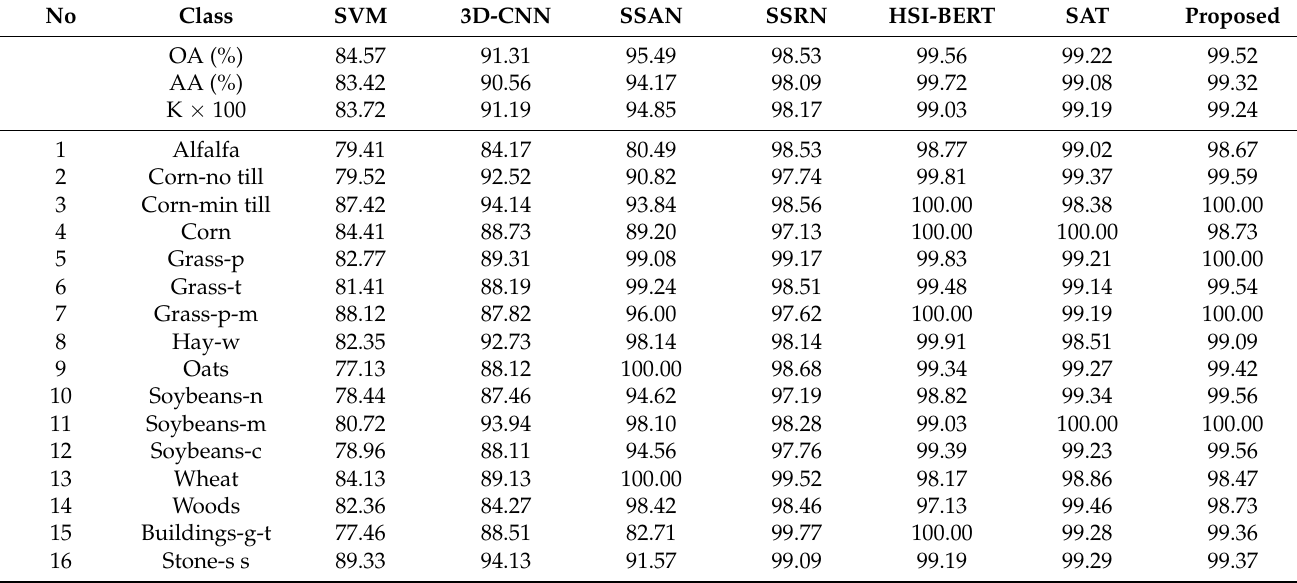
Table 6. Classification results of various methods for the IN